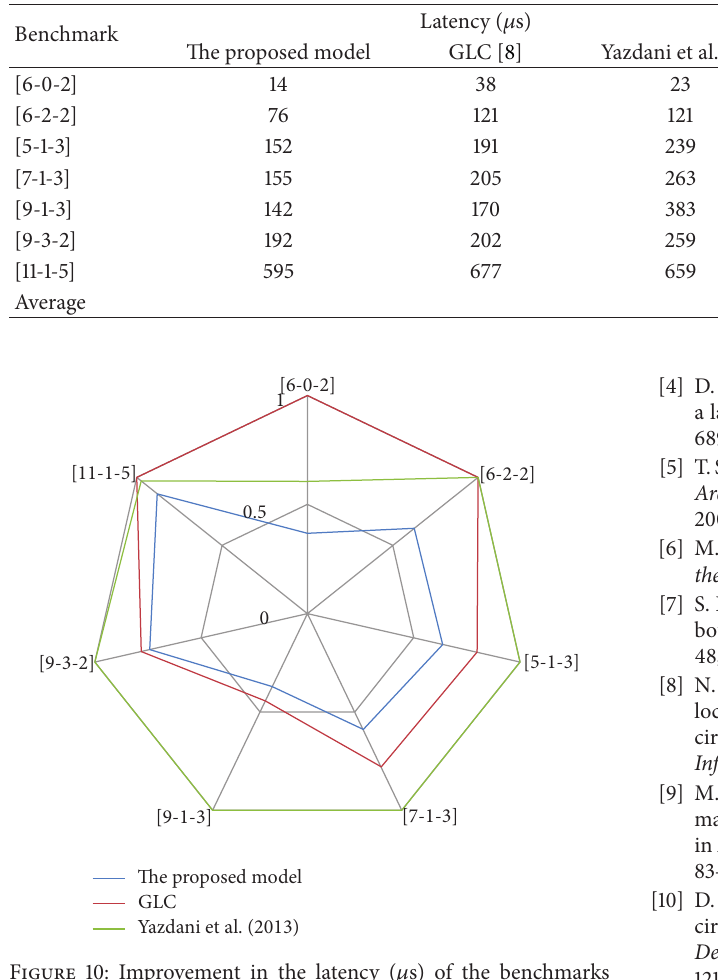
Figure 10: Improvement in the latency ( 𝜇 s) of the benchmarks achieved by the proposed